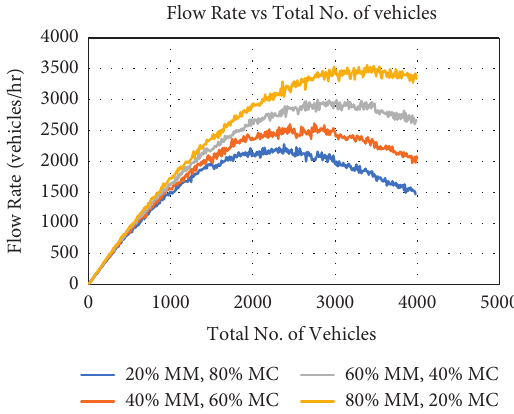
Figure 38: Flow rate vs. total no. of vehicles fundamental diagrams for different compositions of MM and MC.